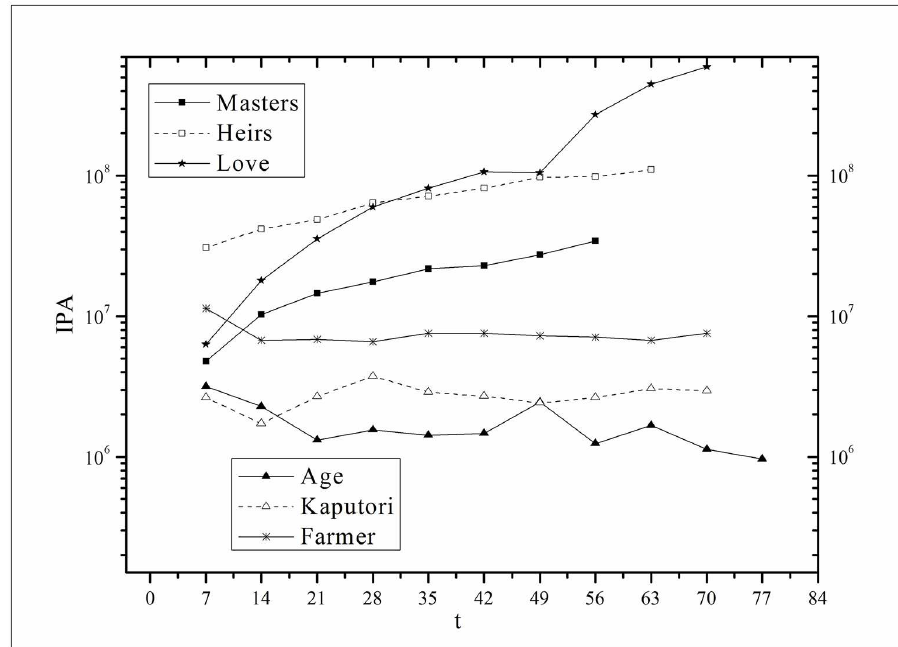
Fig 15. Comparison of IPA of the six datasets.